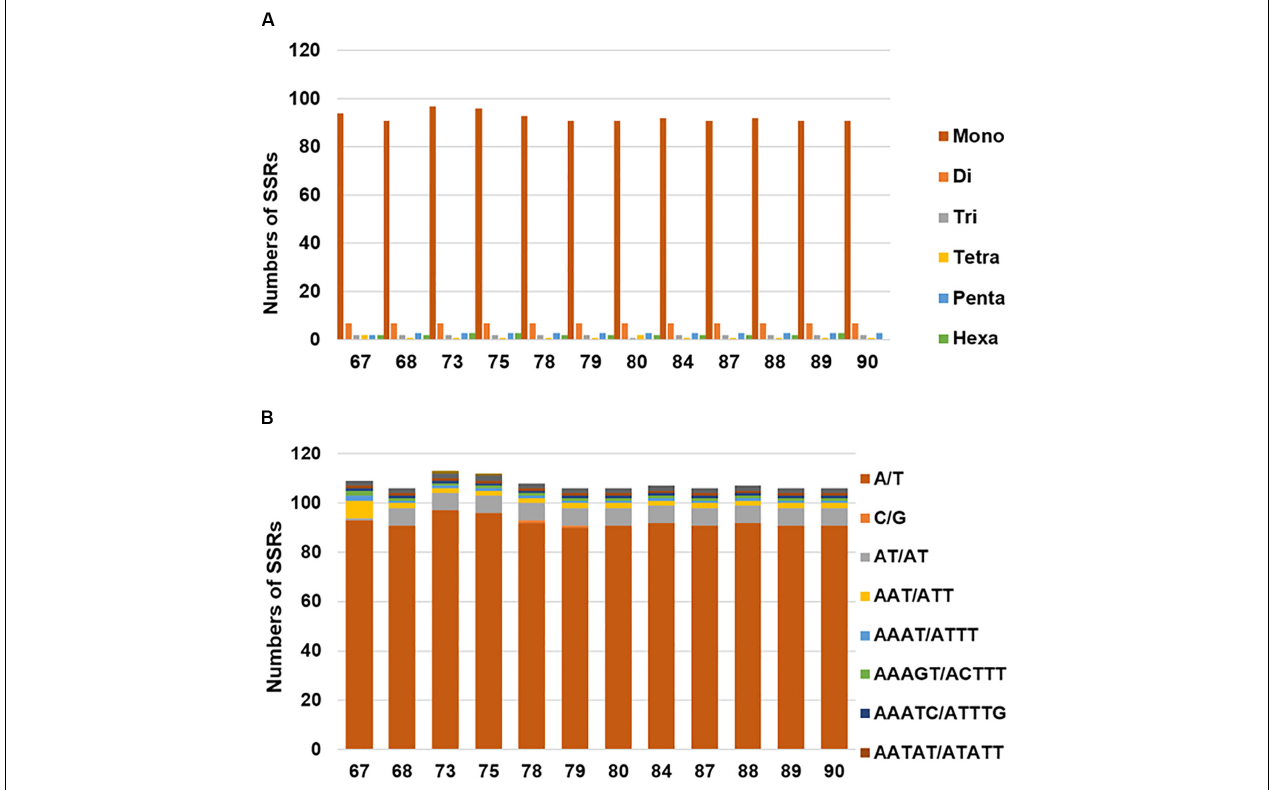
FIGURE 2 | Number and distribution of simple sequence repeats (SSRs) in the 12 H. brasiliensis cp genomes. (A) Number of SSR types in the 12 H. brasiliensis chloroplast genomes; (B) distribution of SSRs in the 12 H. brasiliensis chloroplast genomes. TABLE 4 | Levels of nucleotide variation in the cultivated and wild H. brasiliensis cp genomes. Species